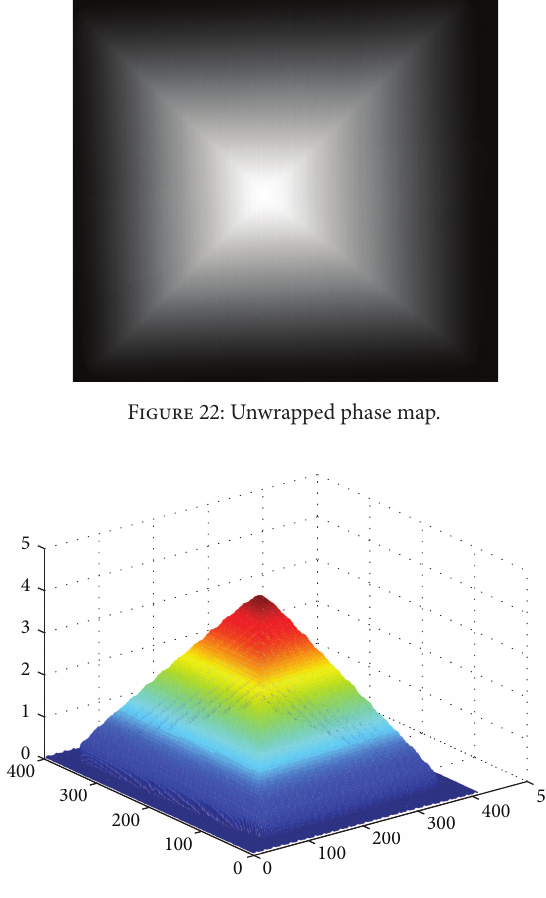
Figure 23: Three-dimensional reconstruction of the pyramid whit real values of height.